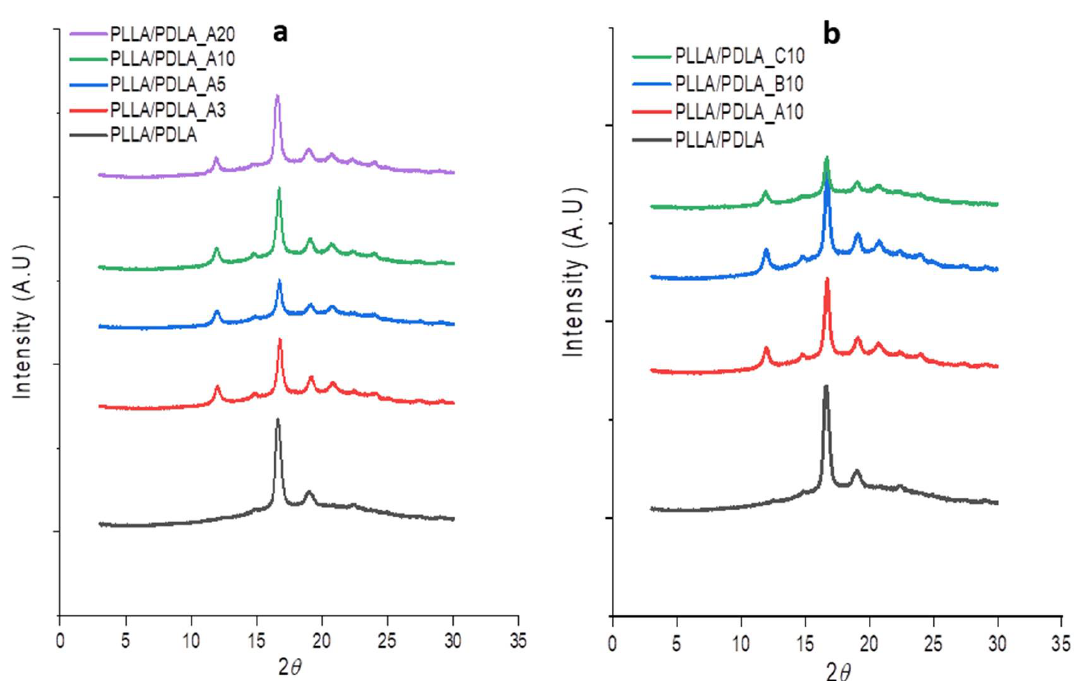
Figure 2. The XRD pattern of PLLA/PDLA blends: ( a ) PLLA/PDLA blends with different s-PLA crystallites contents, ( b ) PLLA/PDLA blends with different s-PLA particle sizes.